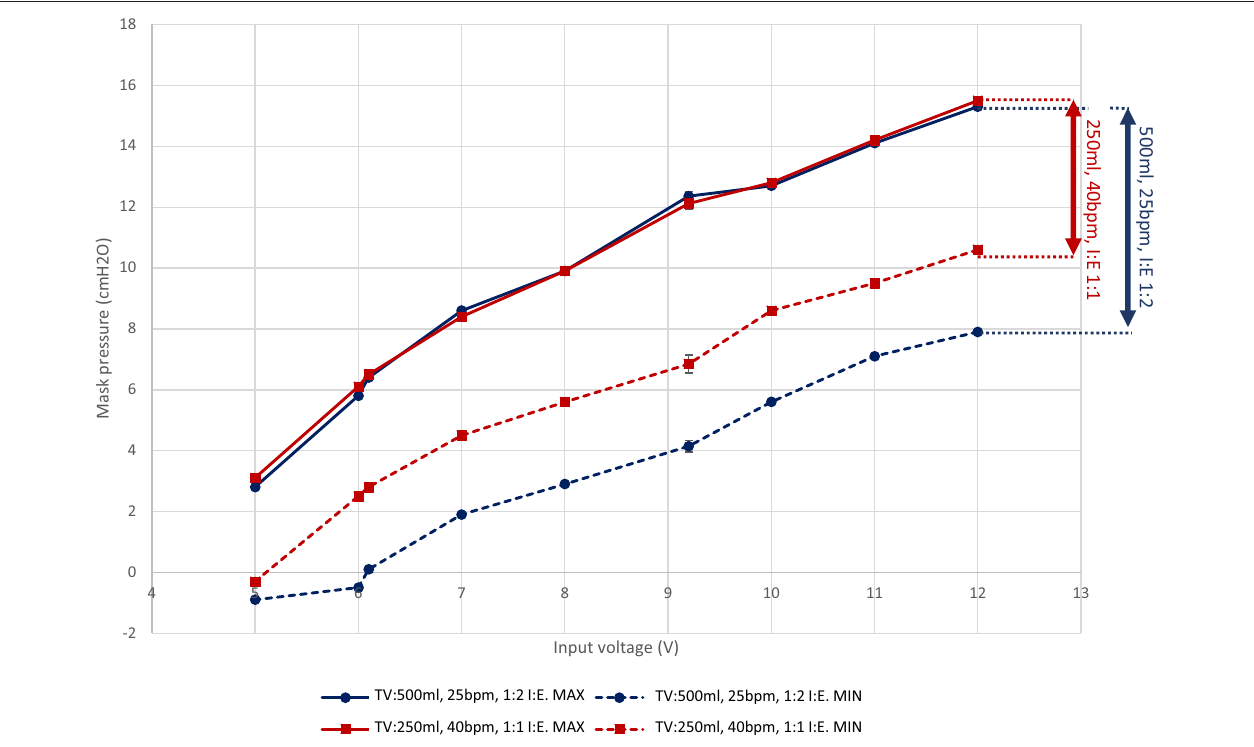
FIGURE 3 | The pressure response of the LeVe Blower with varying supply voltage for different simulated respiratory regimes. Each measurement point represents the mean min/max pressure over 10 breathing cycles (defined as inspiration followed by expiration). Indicative standard error bars for these measures are indicated and range from 0.14 to 0.29cm H 2 O. Tidal Volumes (TV) of 500 and 250ml were simulated at 25 breaths per minute (BPM) and different inspiration:expiration (IE) ratios. Connecting lines show the estimated response between measurement points using linear interpolation. Pressures are gauge pressures with sub-ambient pressures recorded within the breathing circuit where inspiration rates are greater than the fan